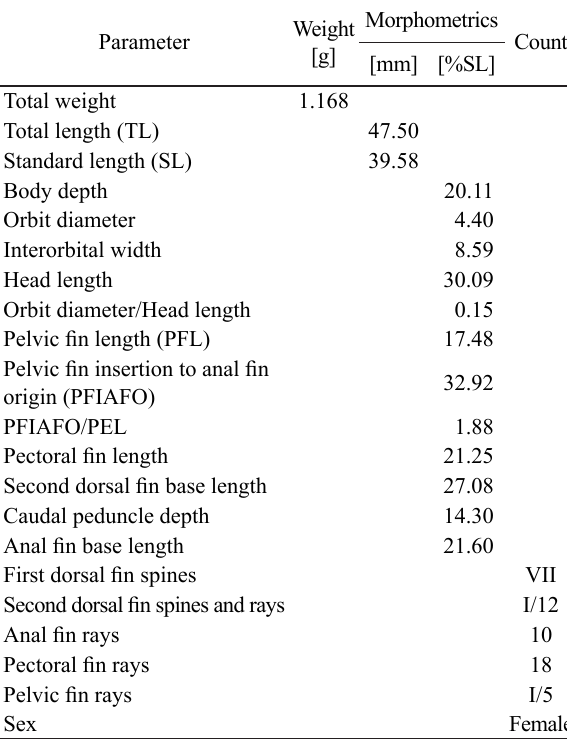
Biometric characteristics of the first specimen of Gobiosoma bosc caught in Belgium in the Zeeschelde estuary near